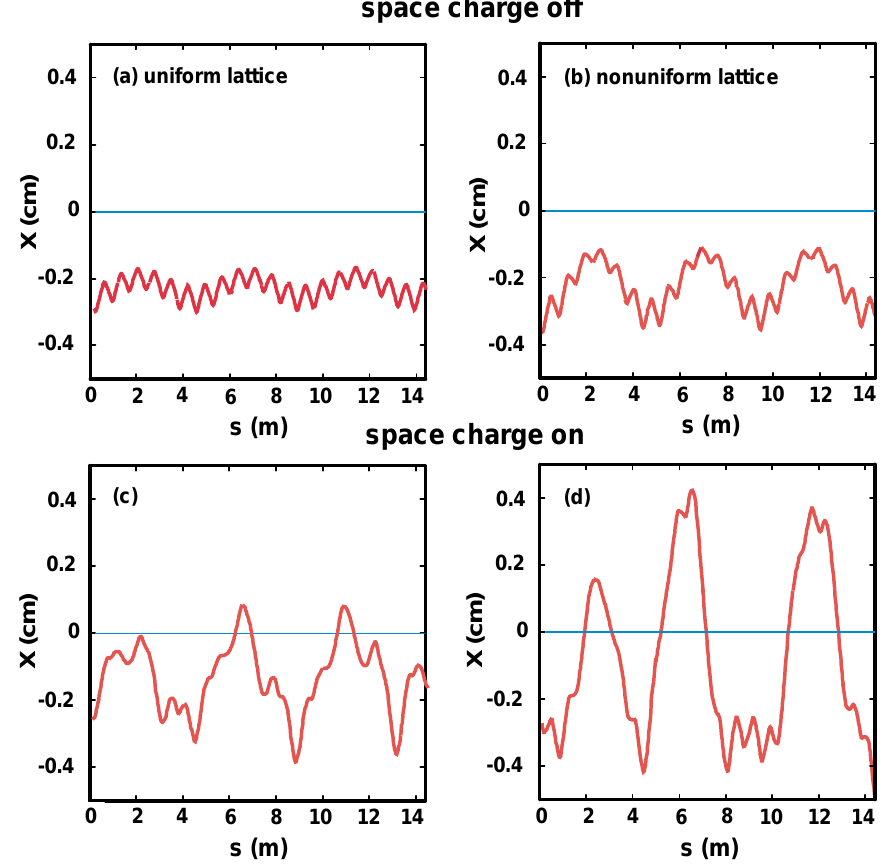
FIG. 4. (Color) Final-lap centroid histories showing the effects of nonuniform acceleration. Cases with the longitudinal space-charge field and the “ear” fields artificially turned off are shown (a) for a lattice with ten uniformly spaced cells and (b) for a similar lattice with the first and sixth cells moved clockwise by one half-lattice period. The corresponding cases including longitudinal space charge and ears are shown, respectively, in (c) and (d). Note that (c) shows the same data as Fig. 3b, but the vertical scale is changed to match the other plots